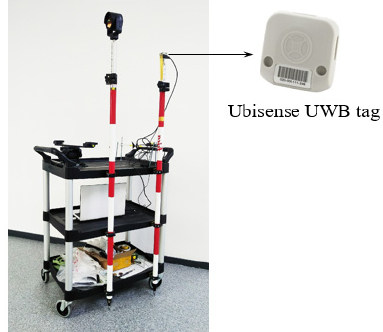
Figure 3. The trolley used in the test.